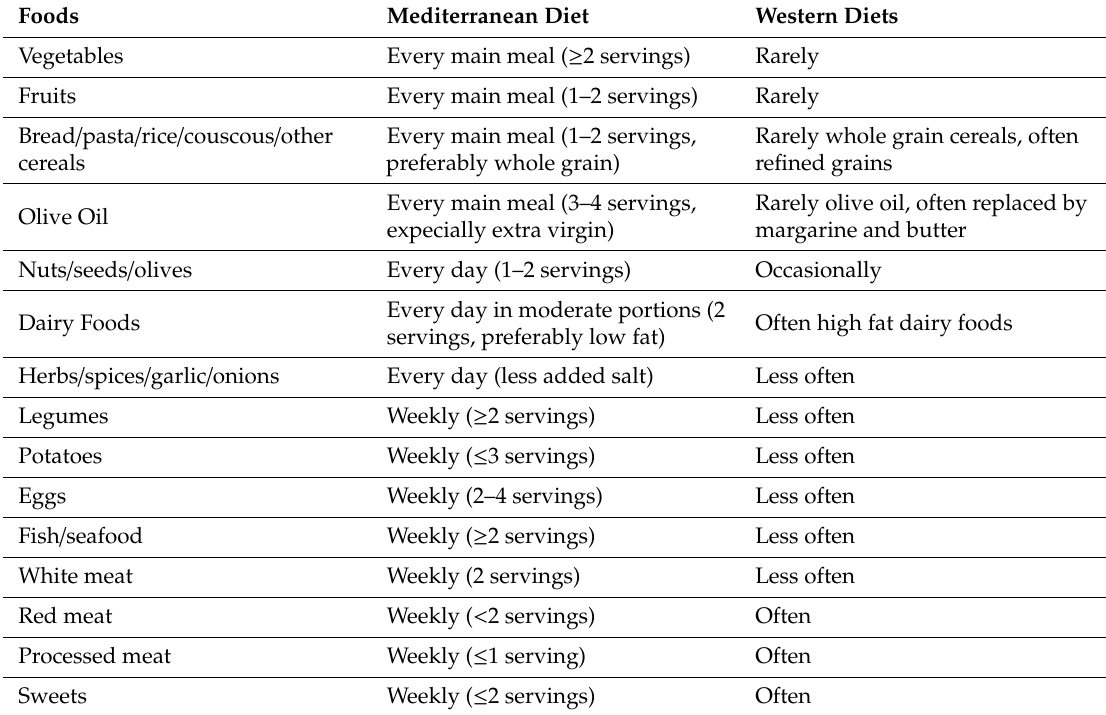
Table 1. Comparison of dietary foods between Mediterranean and Western